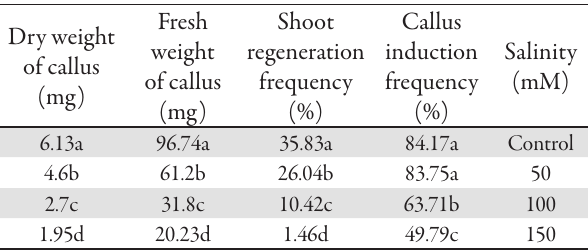
Tab. 3. Means comparison of different treatments of salinity in Foeniculum vulgare Dry weight